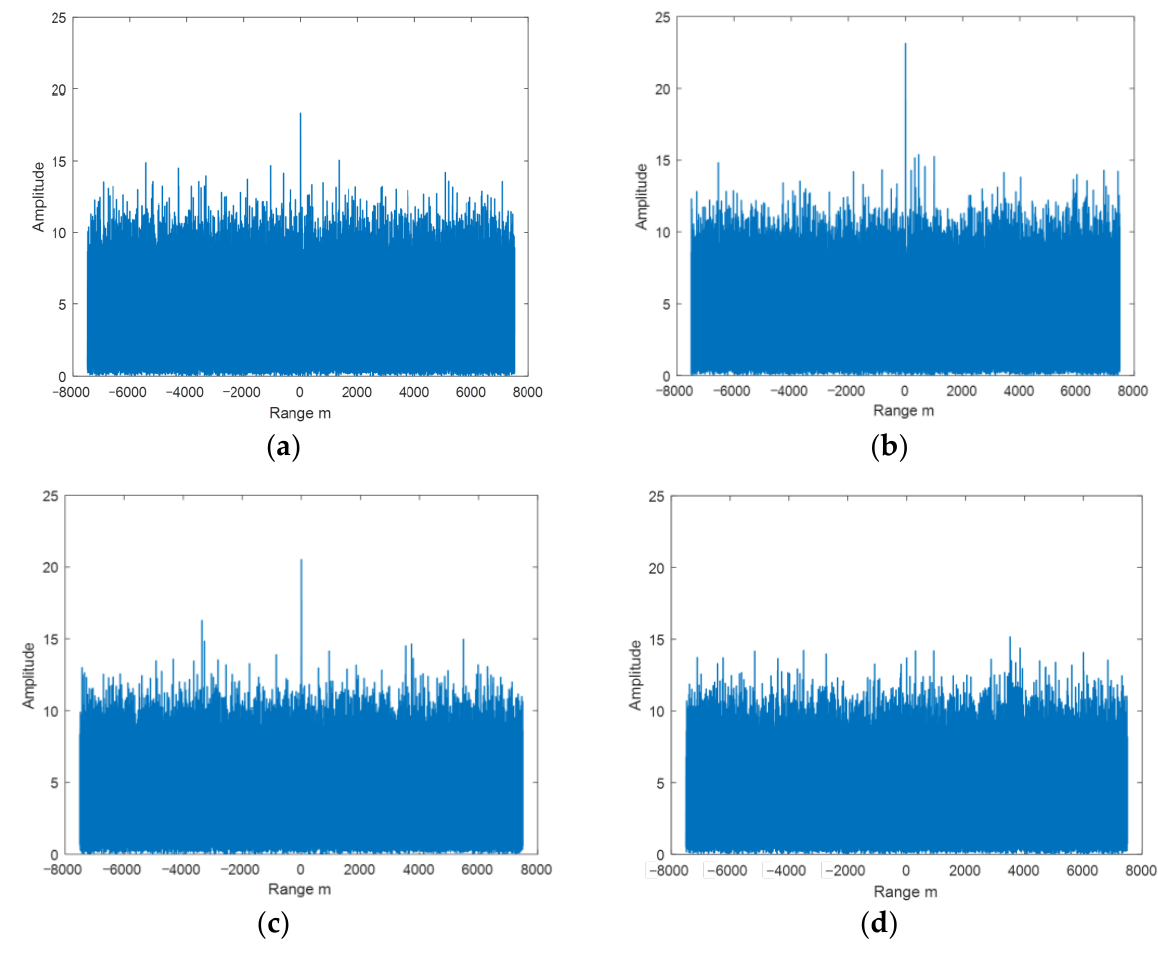
( k ) Figure 15. Partial 40 × 20 sample graph with target under the condition of 0 dB SNR, and the target in unit positions are ( a ) 0.9, ( b ) 0.825, ( c ) 0.75, ( d ) 0.65, ( e ) 0.575, ( f ) 0.45, ( g ) 0.4, ( h ) 0.325, ( i ) 0.25, ( j ) 0.175, and ( k ) 0.1. ( a ) ( b ) ( k ) Figure 16. Partial 40 × 20 sample graph without target under the condition of 0 dB SNR, and the units are ( a ) 400th, ( b ) 800th, ( c ) 1200th, ( d ) 1600th, ( e ) 2000th, ( f ) 2400th, ( g ) 2800th, ( h ) 3200th, ( i ) 3600th, ( j ) 4000th, and ( k ) 4400th. 4.2. Validation Experiments of the Detection Method 4.2.1. Experiment I: Validation of the Detection Method Assume that the target is a single scattering point, satisfying the Swerling0 model. For the signal with 20 echo cycles, the theoretical power accumulation gain of the signal is about 26 dB, and the theoretical power accumulation gain of the noise is about 13 dB,